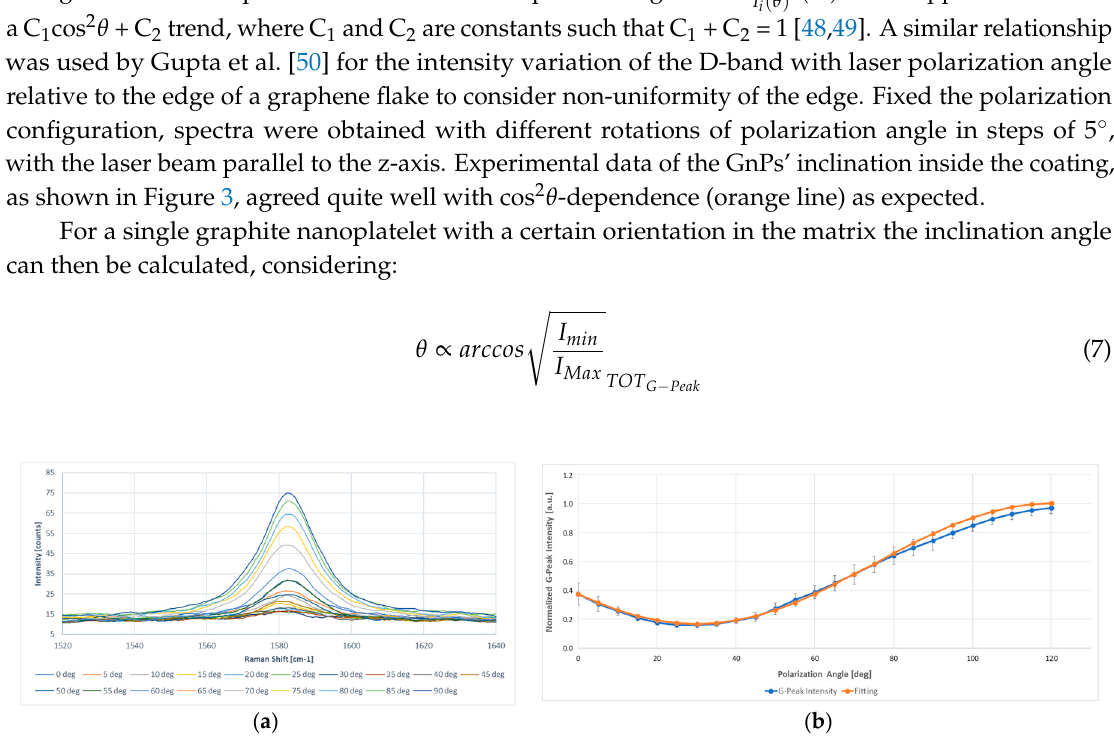
Figure 3. Quantitative determination of the spatial orientation of GnPs by polarized Raman spectroscopy. All Raman spectra were reduced at the same level in order to avoid any shifting and variations of the peaks due to excessive brightness of the copper surface, making comparison easier. ( a ) Intensity attenuation of the G-peak in ‘VV’ polarization configuration for a single graphite nanoplatelet; and ( b ) the comparison between actual data (blue line) and cos 2 θ -dependence fitting curve, with C 1 = 0.833 and C 2 = 0.167. The spectra are excited at 532 nm and recorded at room temperature in the ‘VV’ polarization configuration.